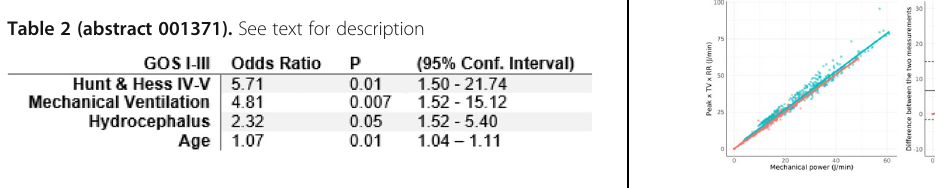
Fig. 2 (abstract 000502). See text for